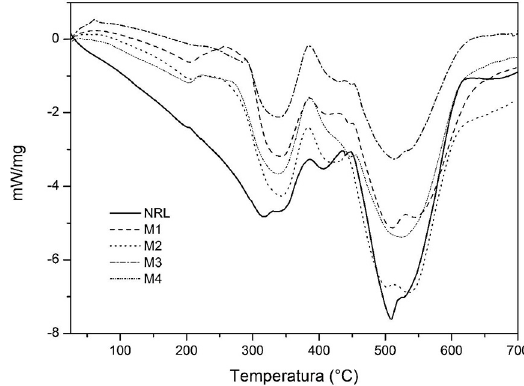
is the initial temperature of thermal degradation, T 0